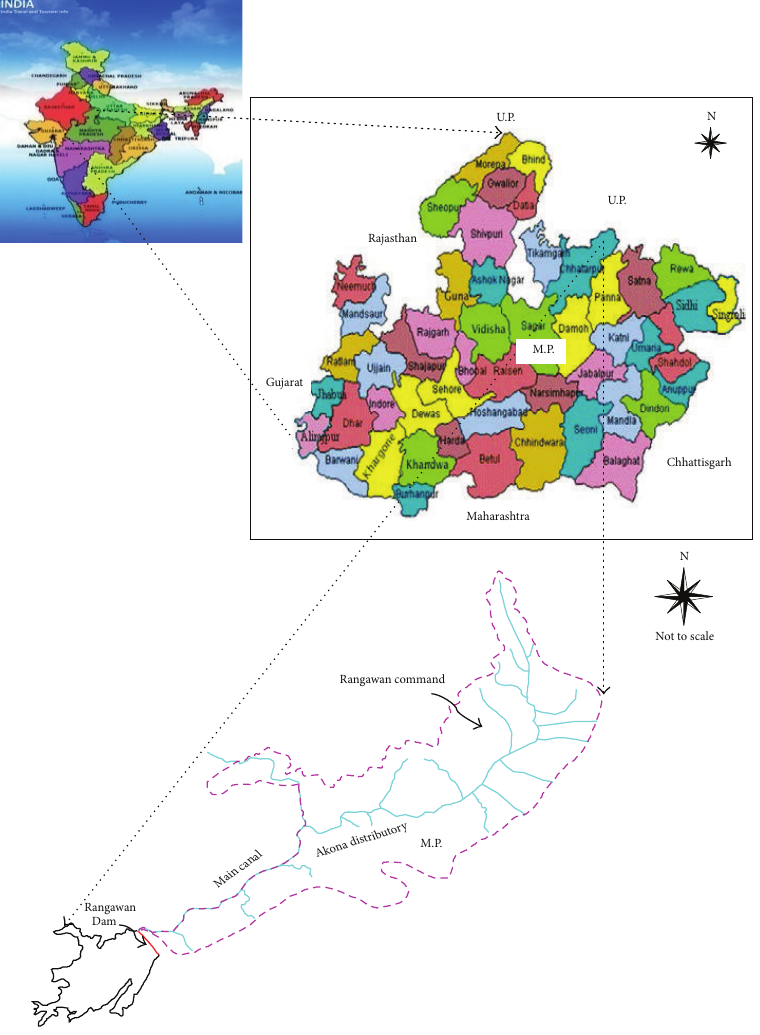
Figure 1: Base map of the study